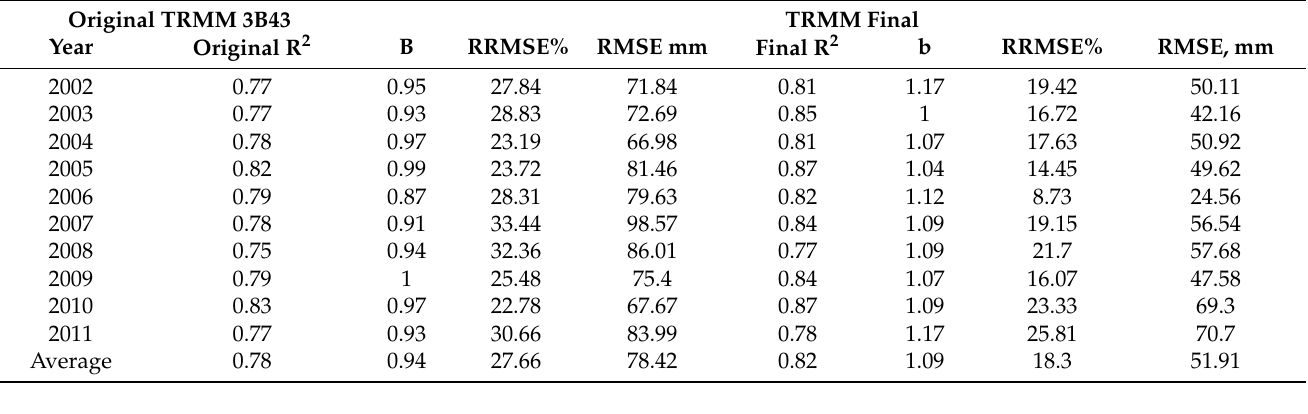
Table 1. Original TRMM and final TRMM.